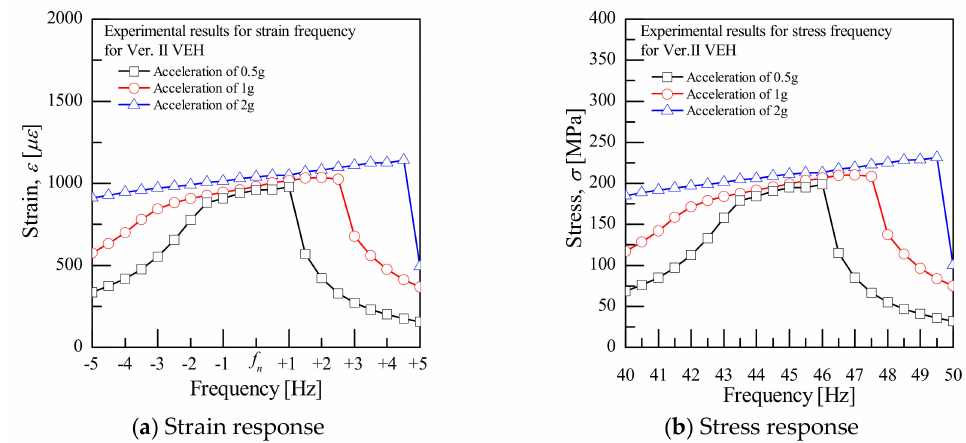
Figure 6. Strain and stress–frequency responses of Ver. II energy harvester.